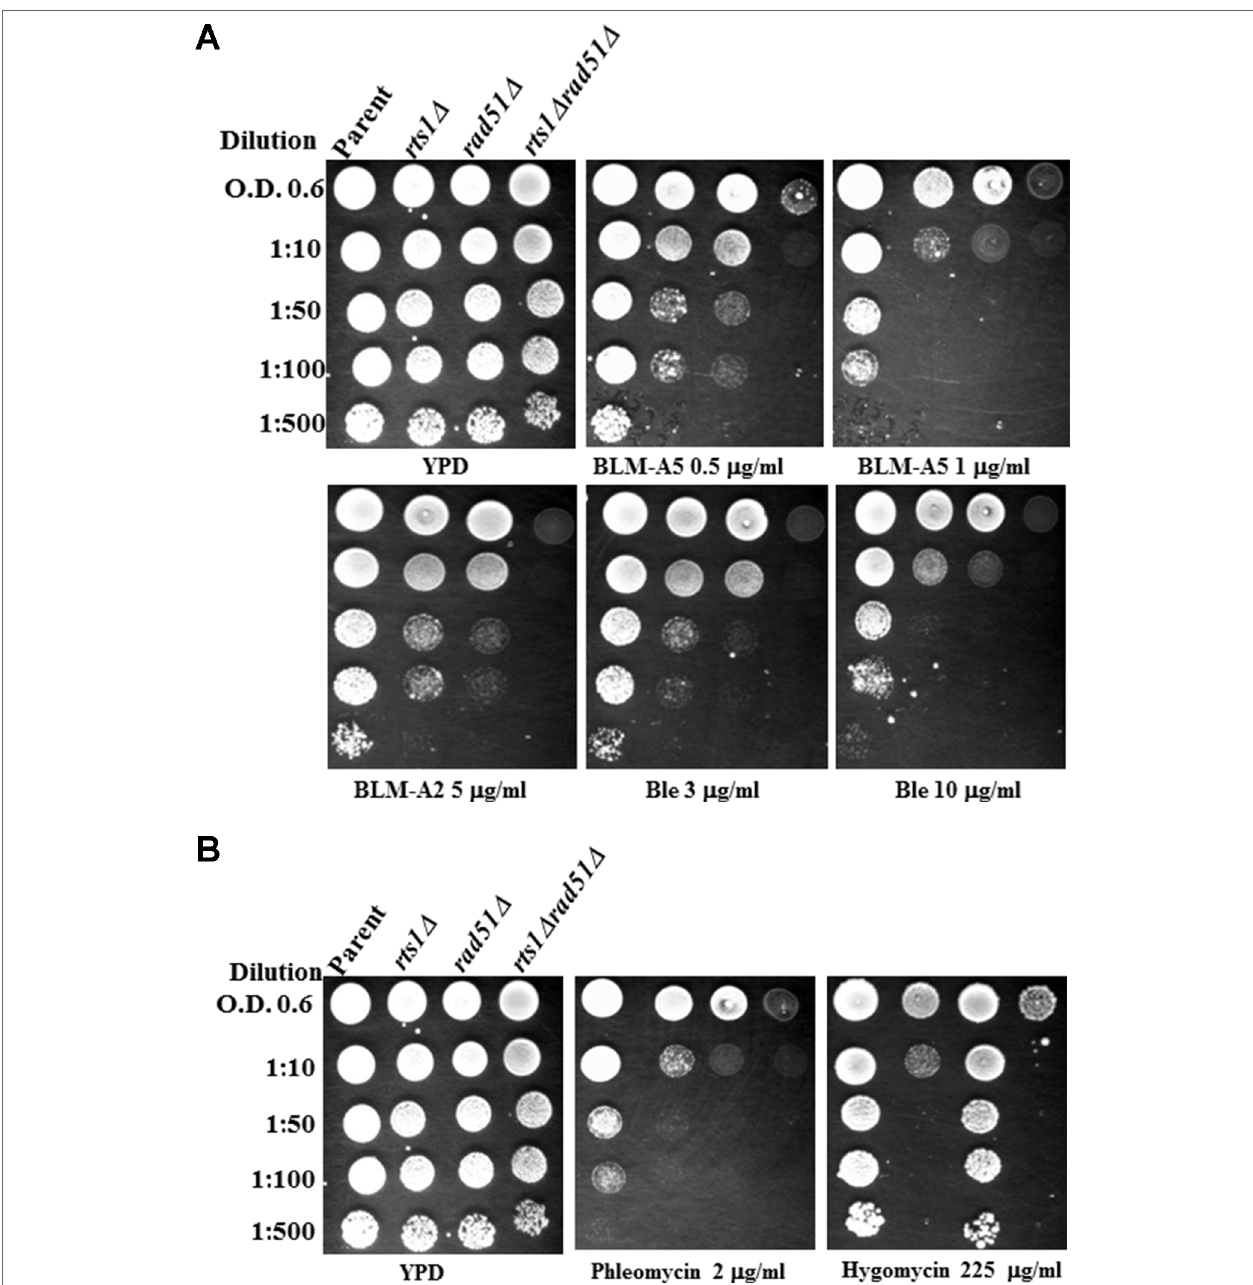
fIGURe 1 | Deletion of the RTS1 gene sensitizes the rad51Δ mutant to bleomycin and phleomycin. (A) Spot test analysis showing the sensitivity of the single and double mutants towards bleomycin. Overnight cultures of the indicated strains grown in yeast extract, peptone, and dextrose (YPD) media were adjusted to OD 600 nm of 0.6, serially diluted and spotted onto plates without and with the indicated concentration of the drugs. (B) Spot test analysis showing the sensitivity of the single and double mutants towards phleomycin and hygromycin. The experiment was performed as figure 1A . The plates were incubated for 48 h at 30°C before photographed. The results are represented of three independent